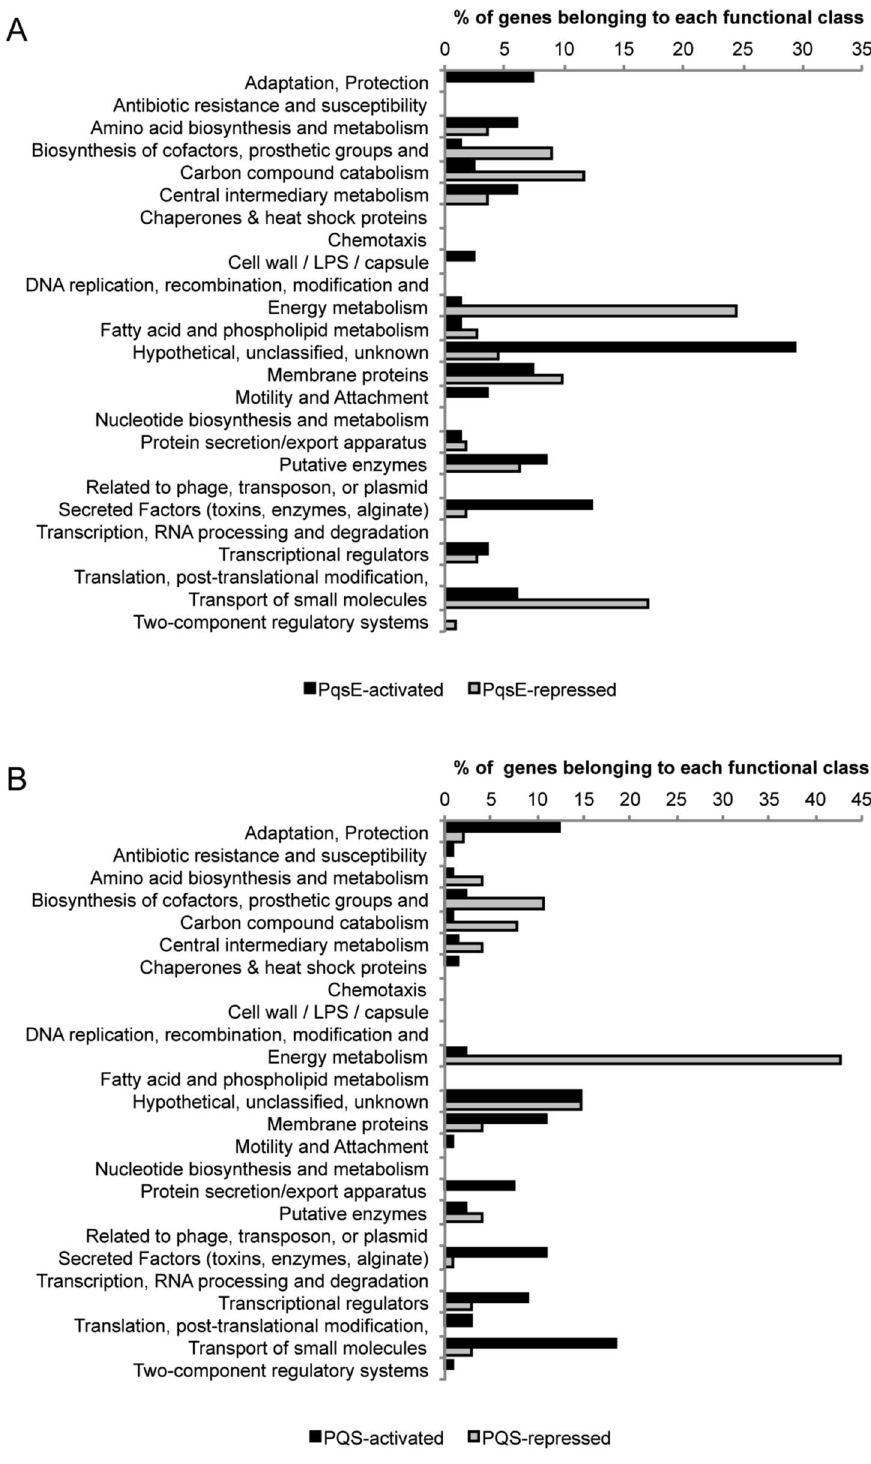
Fig 3. Functional classes of PqsE and PQS controlled genes. Histograms representing the distribution of ( A ) PqsE-controlled and ( B ) PQS-controlled genes accordingto their functional classification. Functional classes are from the Pseudomonas Genome